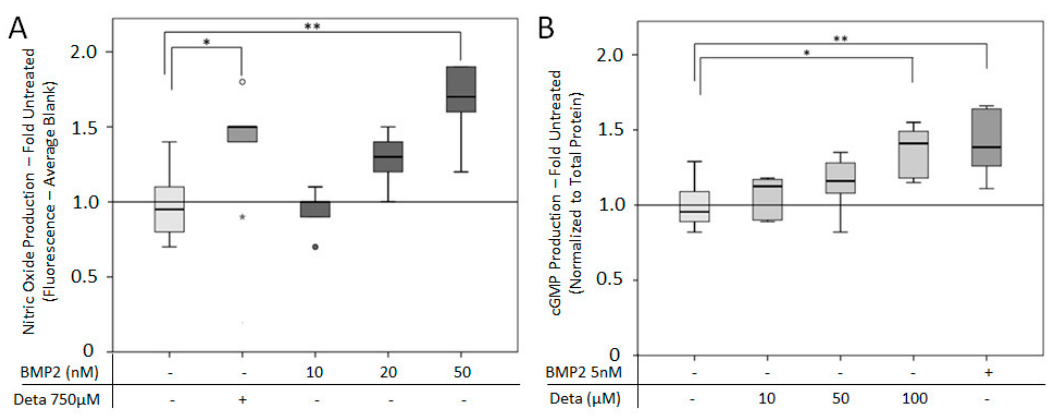
Figure 11. Treating C2C12BRELuc cells with BMP2 stimulated NO signaling. ( A ) NO production quantified by DAF-2-mediated fluorescence and fold comparison to untreated group. C2C12BRELuc cells were stimulated for 2 h with 750 µ M Deta NONOate or 10, 20, or 50 nM BMP2. ( B ) cGMP production in cells after 1 h stimulation with 10, 50, or 100 µ M Deta NONOate or 5 nM BMP2 given as fold comparison to untreated groups. Statistics: Kruskal–Wallis Test followed by Mann-Whitney U test. Mann-Whitney U test significances between samples were assigned if p < 0.05 (*) or p < 0.01 (**). Abbreviation: Deta: = Deta NONOate. Stars and circles indicate outlying values. Replications (A, B) n = 6.